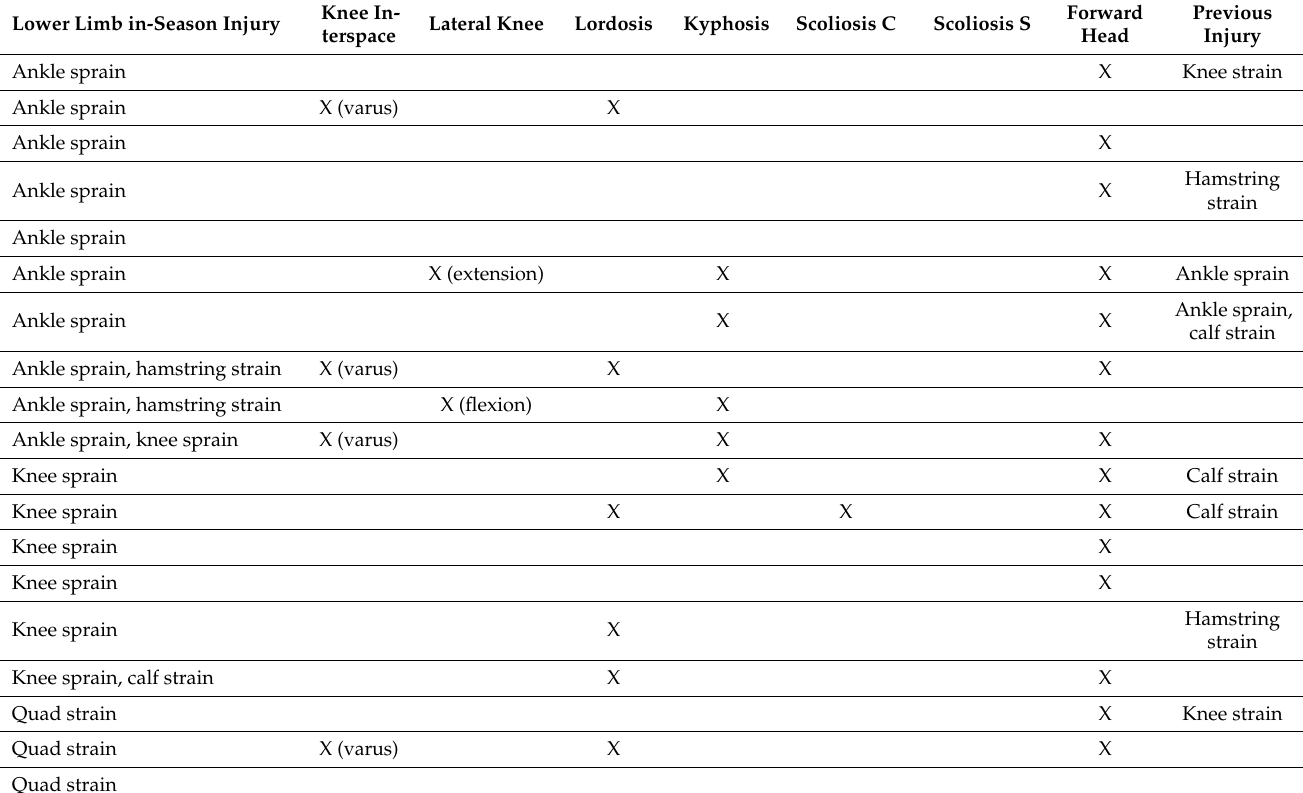
Table 3. Postural deviations * in injured players ( n = 24), with their type of in-season injury, and if applicable, their previous